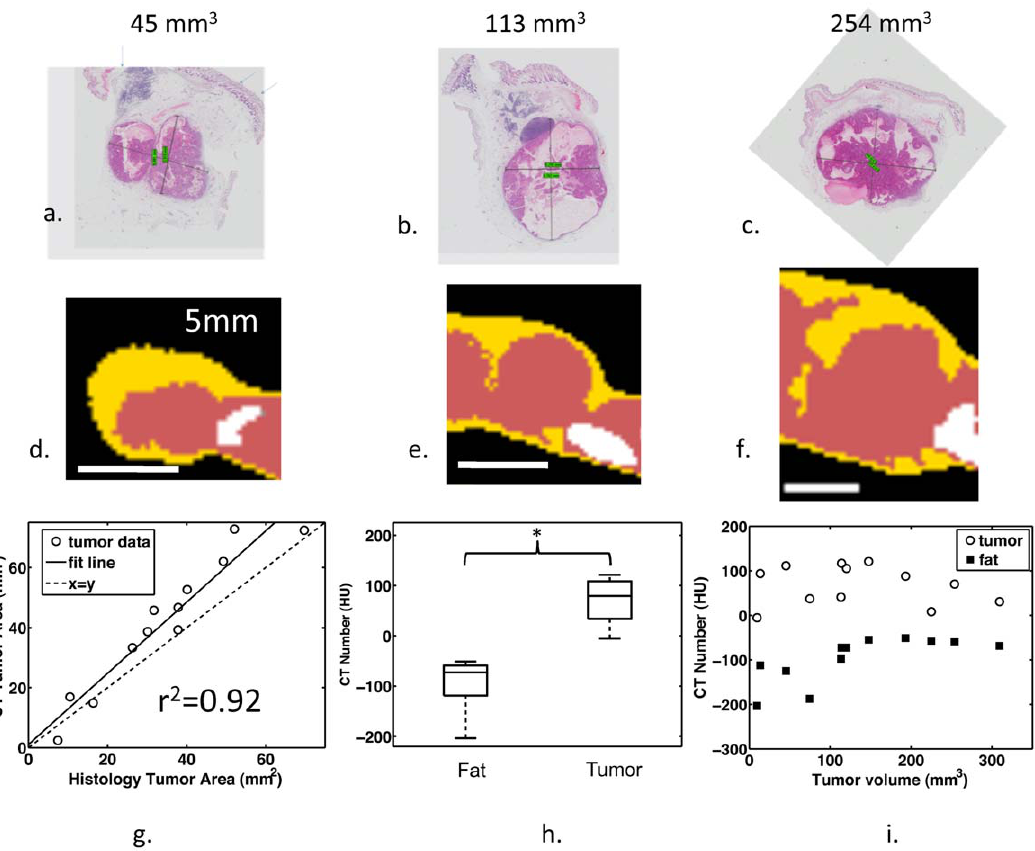
Figure 4. CT segmentation corresponds with histology. (a–c) Histology and (d–f) corresponding segmented CT slices for tumors of diameters 45 mm 3 , 113 mm 3 , and 254 mm 3 , respectively. (g) The tumor area in histology is correlated with the cross-sectional area of protein-rich tissue detected by CT (r 2 =0.92, slope=1.2). (h) The average HU of 1 mm 2 ROIs in the fat pad is less than within the tumor when averaged across all tumors (p , 0.05). (i) The CT number is higher within the tumor compared to the surrounding fat pad for all tumors.